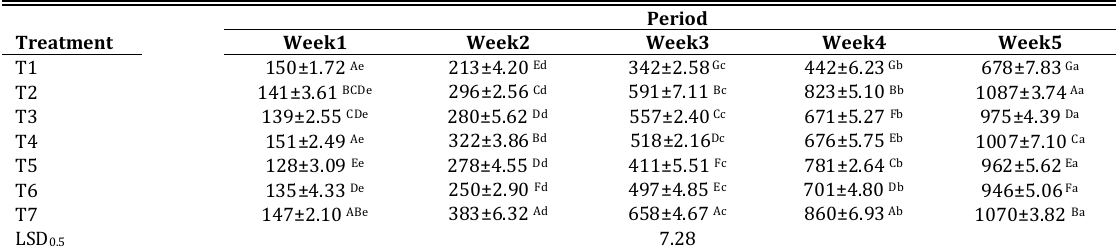
Table 5. Effect of different levels of Spirulina , probiotic, prebiotic, and antibiotic with or without E. faecalis infection on feed conversion ratio (g:g) of broiler 1 Treatment